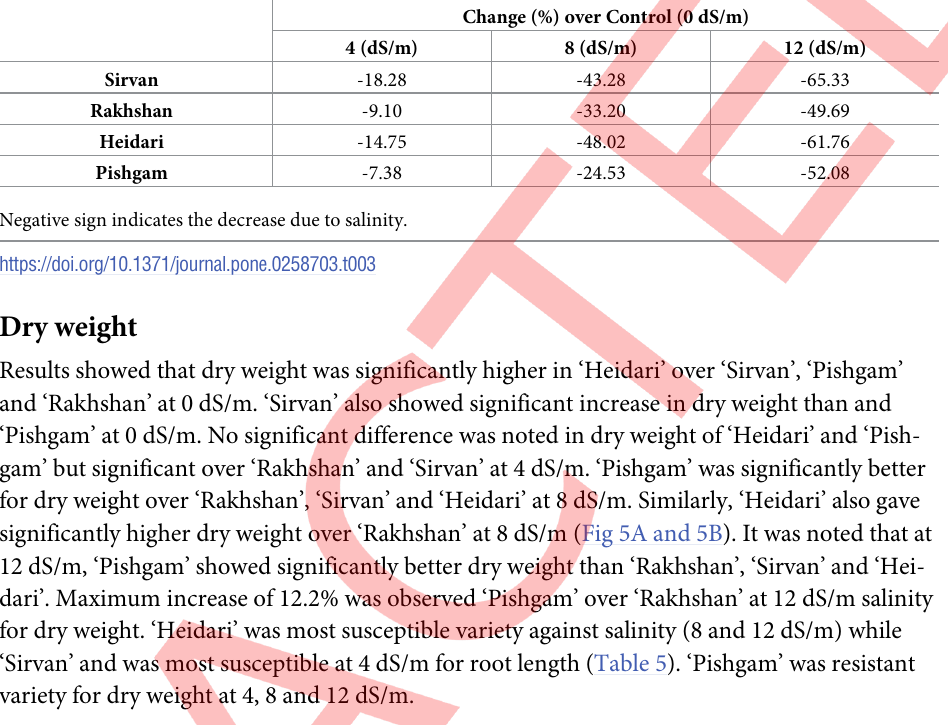
Table 3. Percentage change in root length of different wheat varieties as influenced by variable salinity levels. Wheat Varieties